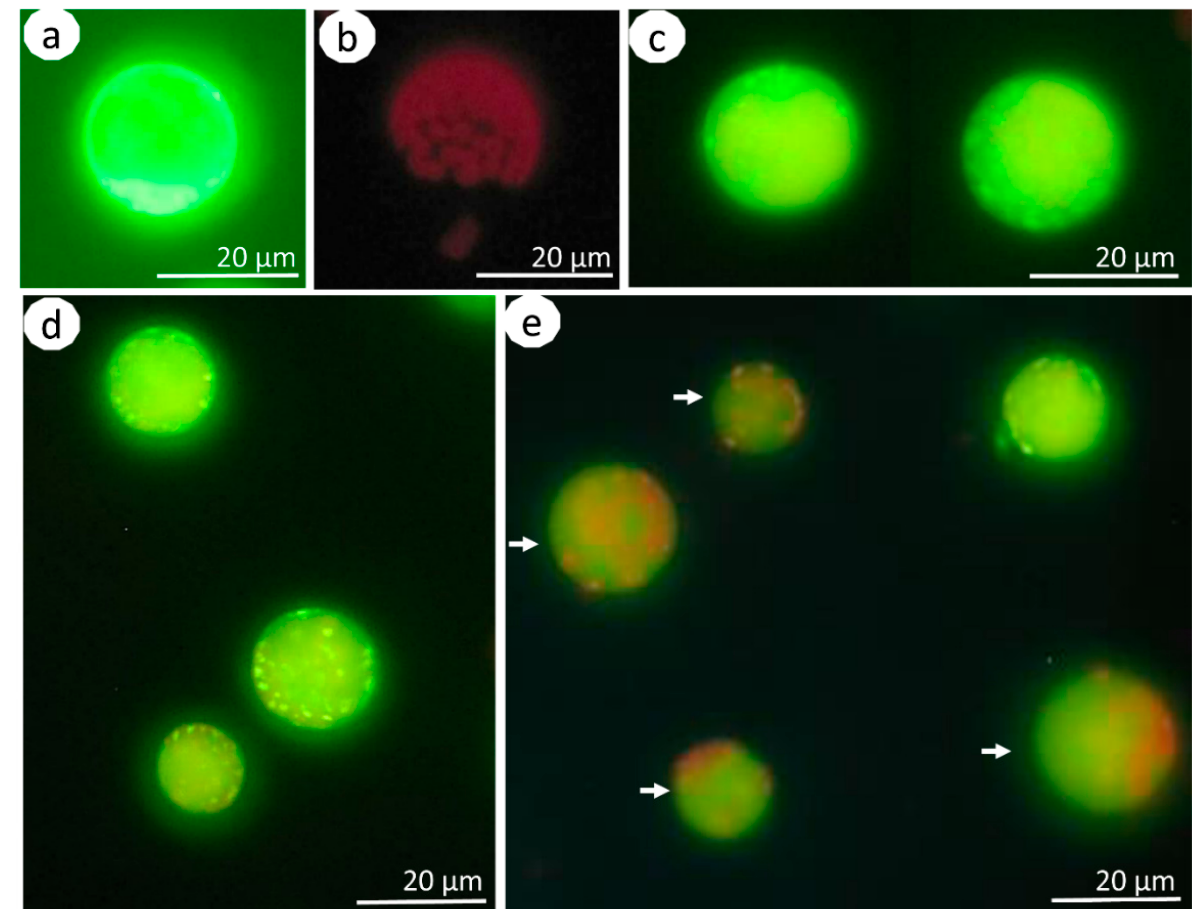
Figure 2. Protoplasts of Brassica oleracea L. var. capitata stained with H 2 DCFDA and in controls. Positive control (cell from the H 2 O 2 -treated culture) ( a ); negative control (cell from the culture without any treatment) ( b ); exemplary view of polyamine-treated cells 24 h after isolation ( c ). Protoplast cultures that were treated with 10 µ M of Put after 24 ( d ) and 48 ( e ) hours of culture. The arrows in subfigure (e) mark the cells with yellow-green fluorescence of the cytoplasm with red signals breaking through from the chloroplasts.